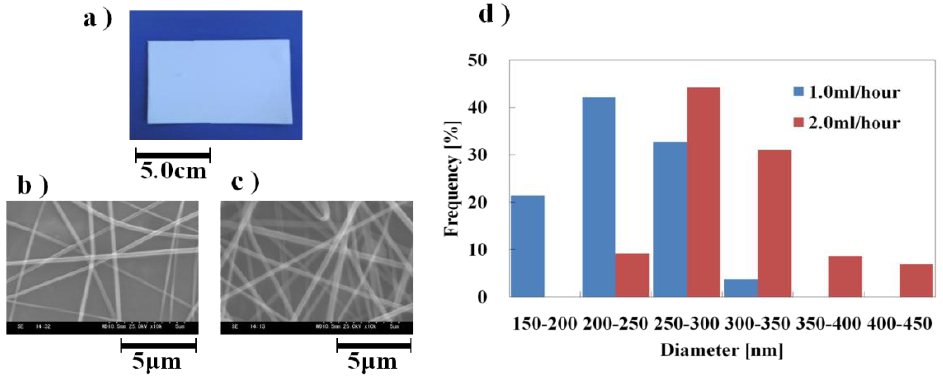
Figure 4. The method of introducing the anisotropic structure into the nanofiber gel. ( a ) Electrospinning at a flow rate of 2.0 mL/hour (sprayed for 30 minutes). ( b ) Electrospinning at a flow rate of 1.0 mL/hour (sprayed for 60 minutes). ( c ) Drying in 50 °C over night. ( d ) Cutting into 15 mm × 3 mm × 200